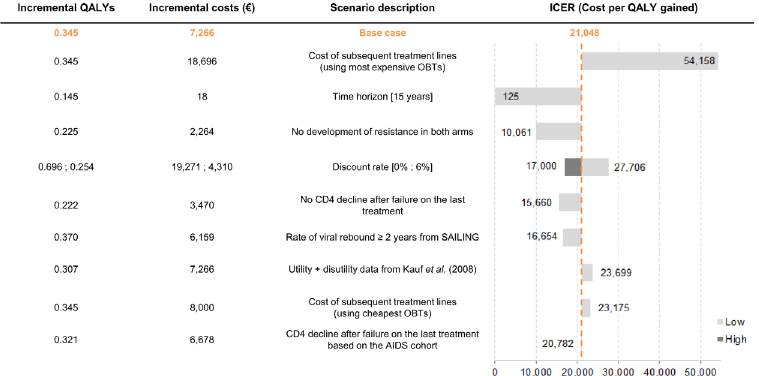
Fig 3. DSA — 7 most influential parameters. AIDS: Acquired Immunodeficiency Syndrome; CD4: Cluster of Differentiation 4; DSA: Deterministic Sensitivity Analysis; ICER: Incremental Cost-Effectiveness Ratio; QALY: Quality Adjusted Life Year; OBT: Optimized Background